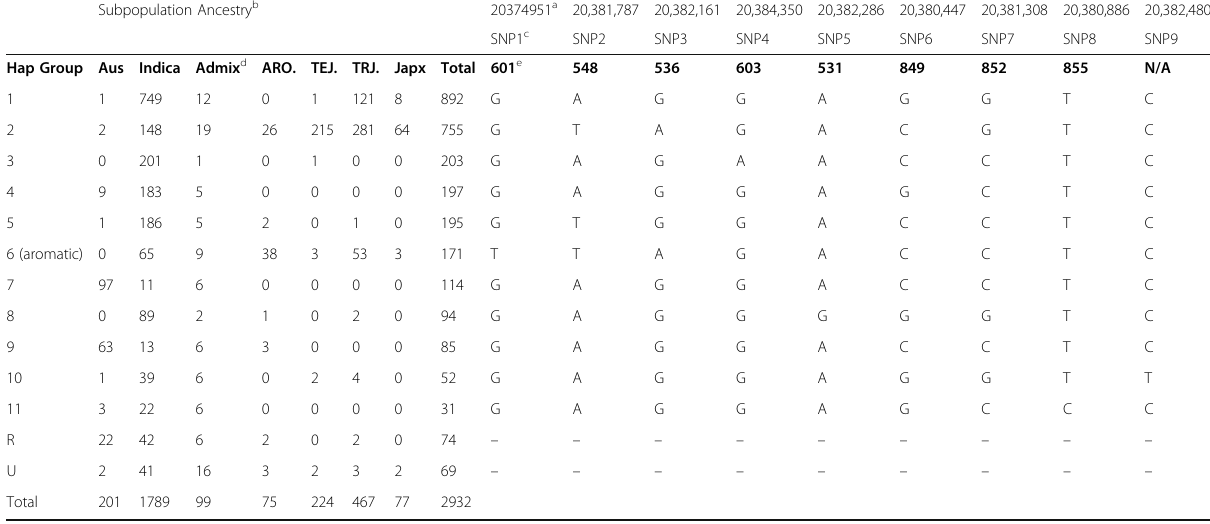
Table 1 Haplotype characterization of the BADH2 gene across the global rice diversity panel Subpopulation Ancestry b